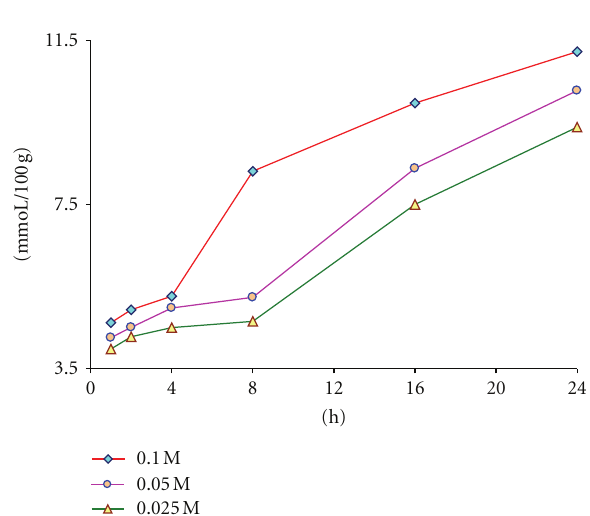
Figure 3: E ff ect of the time and concentration of Na 2 HPO 4 solution on the extractability of wood